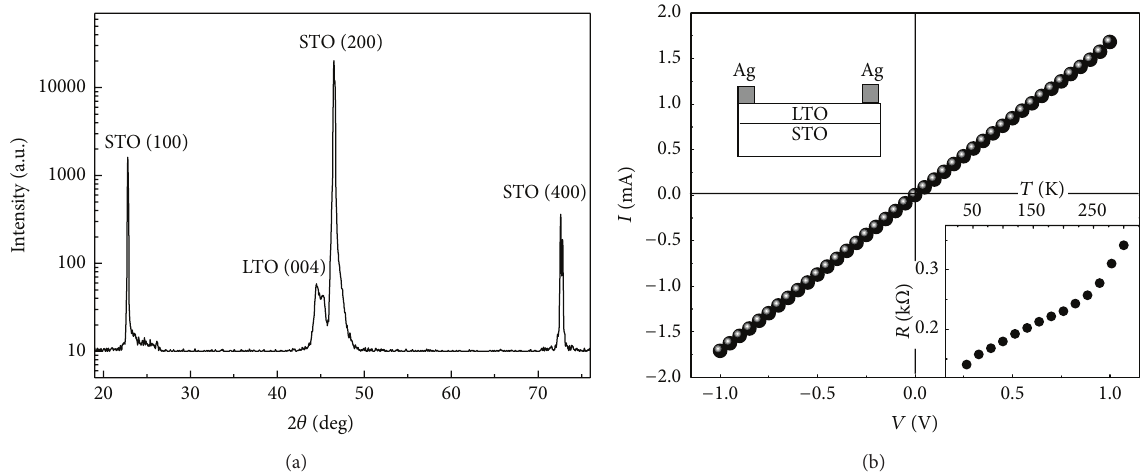
Figure 1: (a) XRD pattern of LTO/STO sample. (b) The typical I - V characteristics of the LTO/STO at room temperature. The top inset shows the schematic measurement setup. The bottom inset shows the temperature dependence of resistance of LTO/STO film.